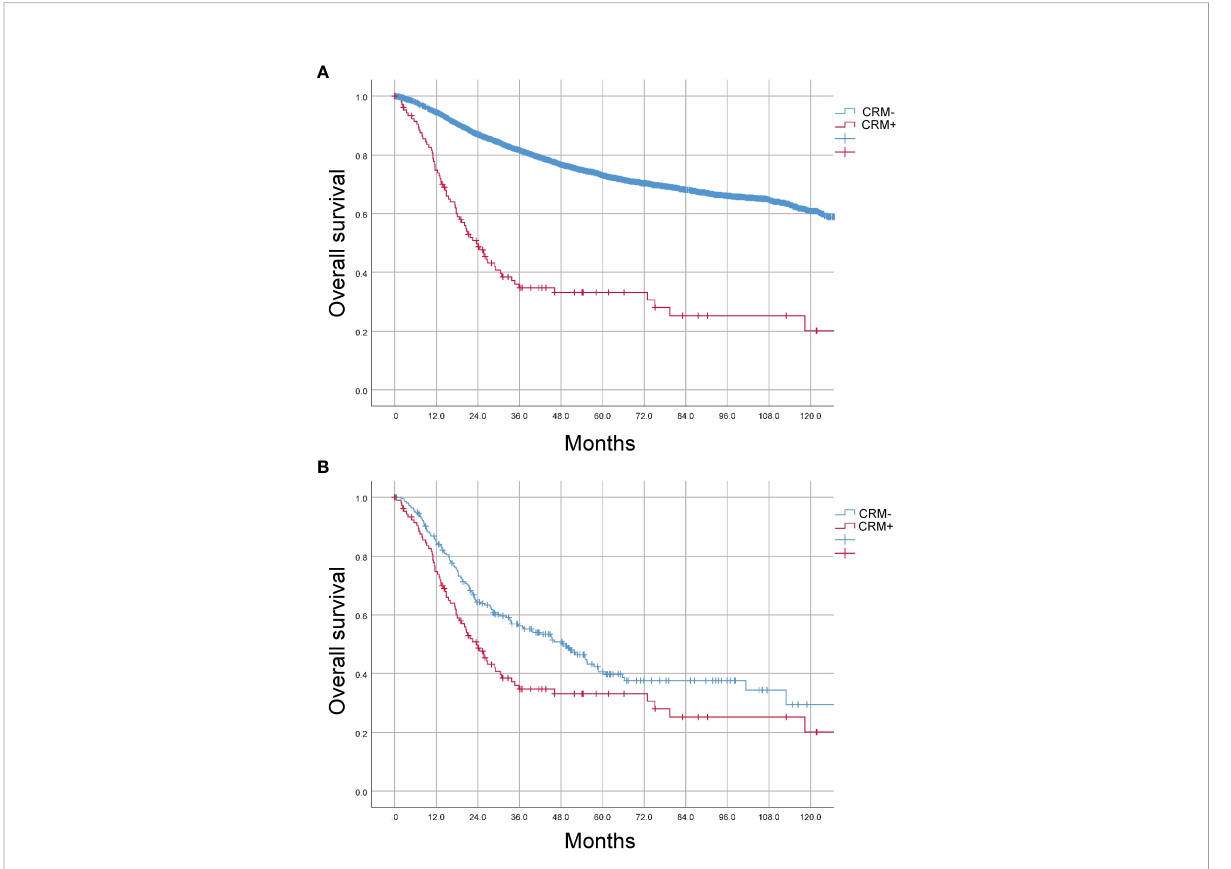
FIGURE 1 Prognostic value of CRM status in CC patients. (A) Kaplan-Meier (K-M) curves were plotted before PSM. (B) Kaplan-Meier (K-M) curves were plotted after